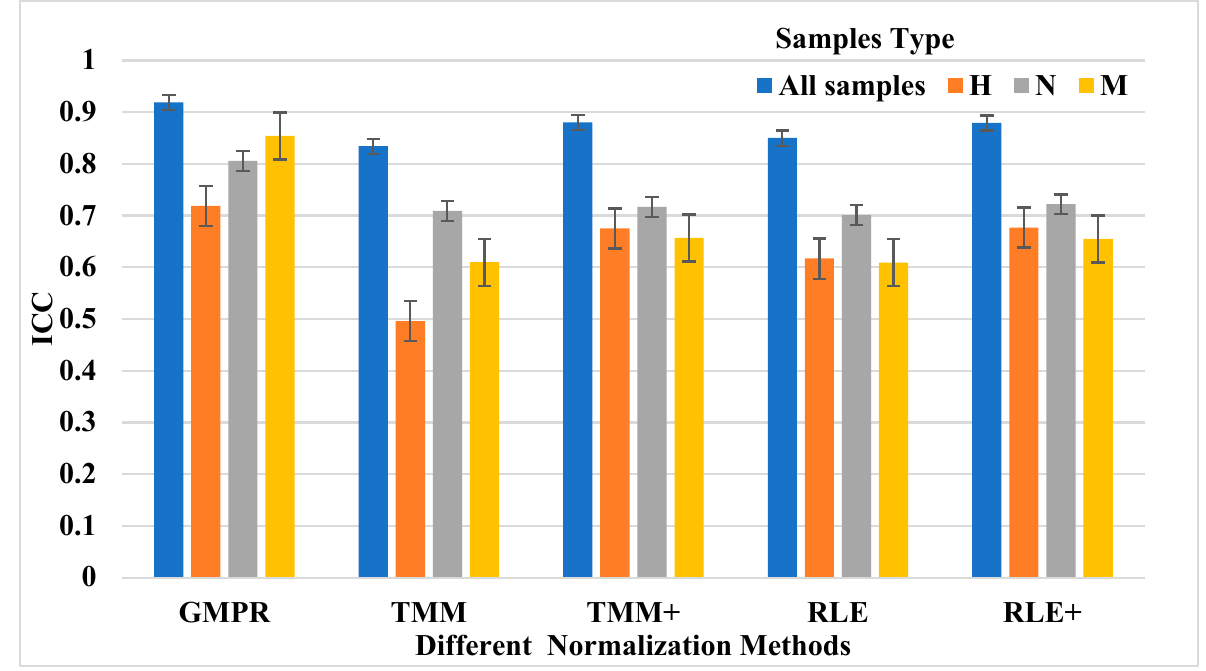
Figure 2. ICC of four samples under different normalization methods. The horizontal axis represents different normalization methods (Trimmed Mean of M values (TMM), add a pseudocount for TMM (TMM+), Relative Log Expression normalization (RLE), add a pseudocount for RLE (RLE+), and the vertical axis represents the ICC value.